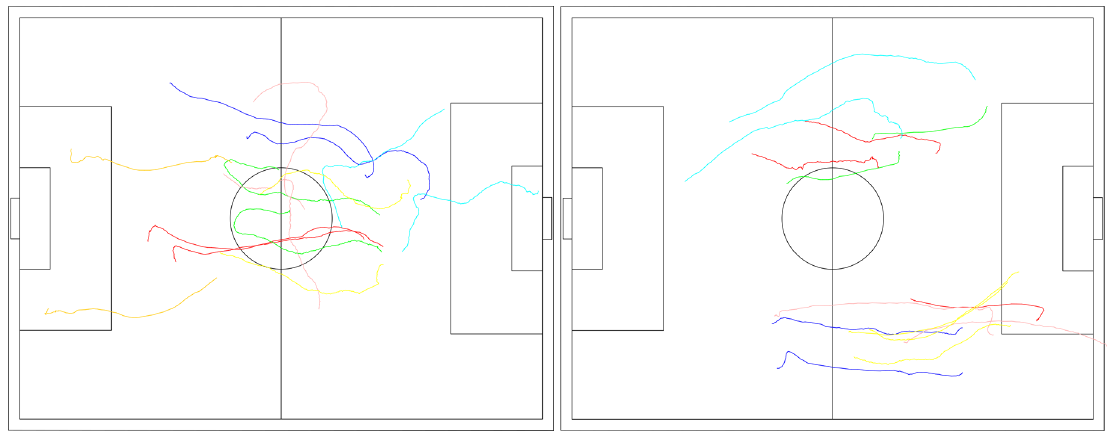
Figure 12. A comparison of movement patterns for players with different roles. Left : center midfielder. Right : wing player.